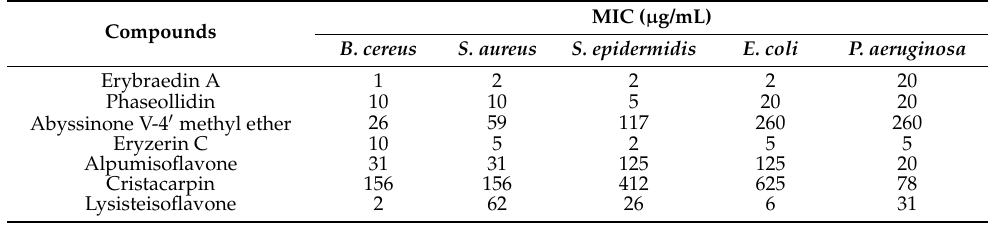
Table 16. Antibacterial activity of isoflavones and their derivatives from bark of Erythrina lysistemon